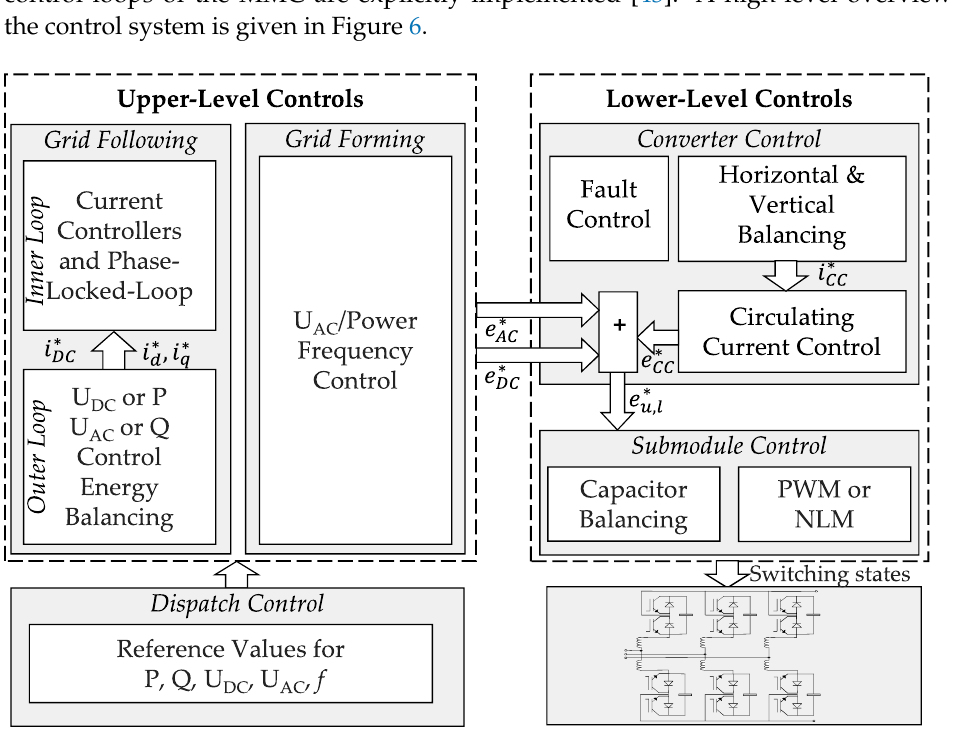
Figure 6. Cascaded vector control scheme for controlling the